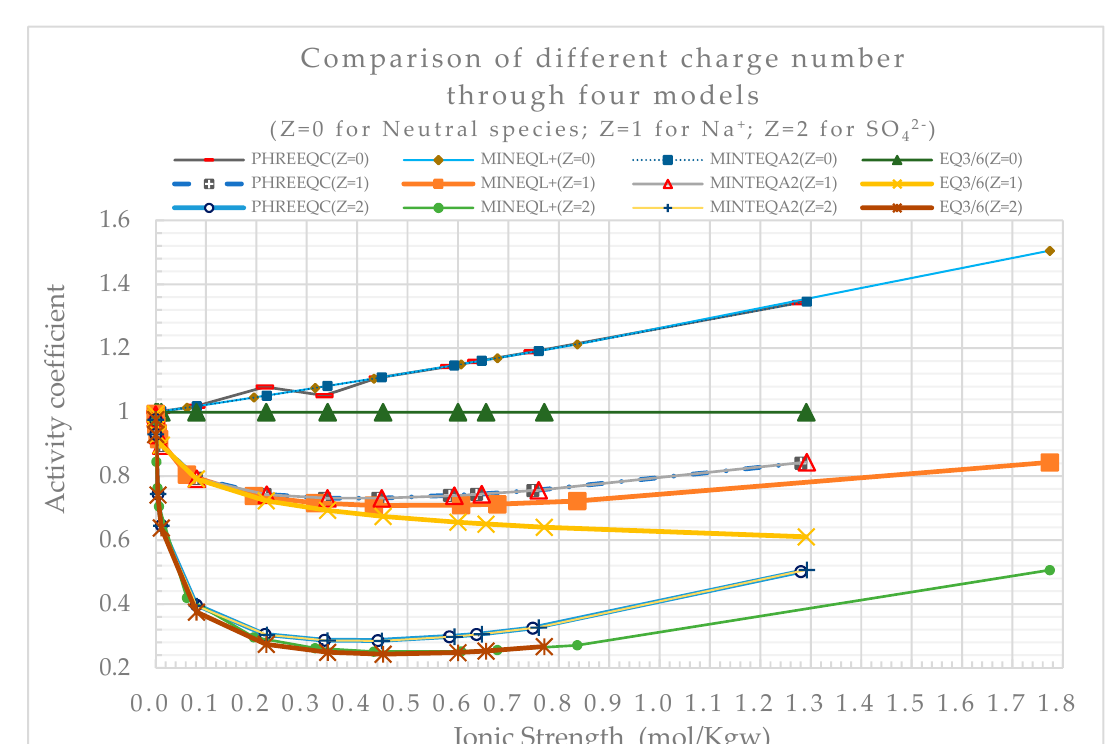
Figure 11. Comparison of the activity coefficients of Na + , SO 42 − and neutral species in relation to the ionic strength calculated by the Davies equation through the four models.